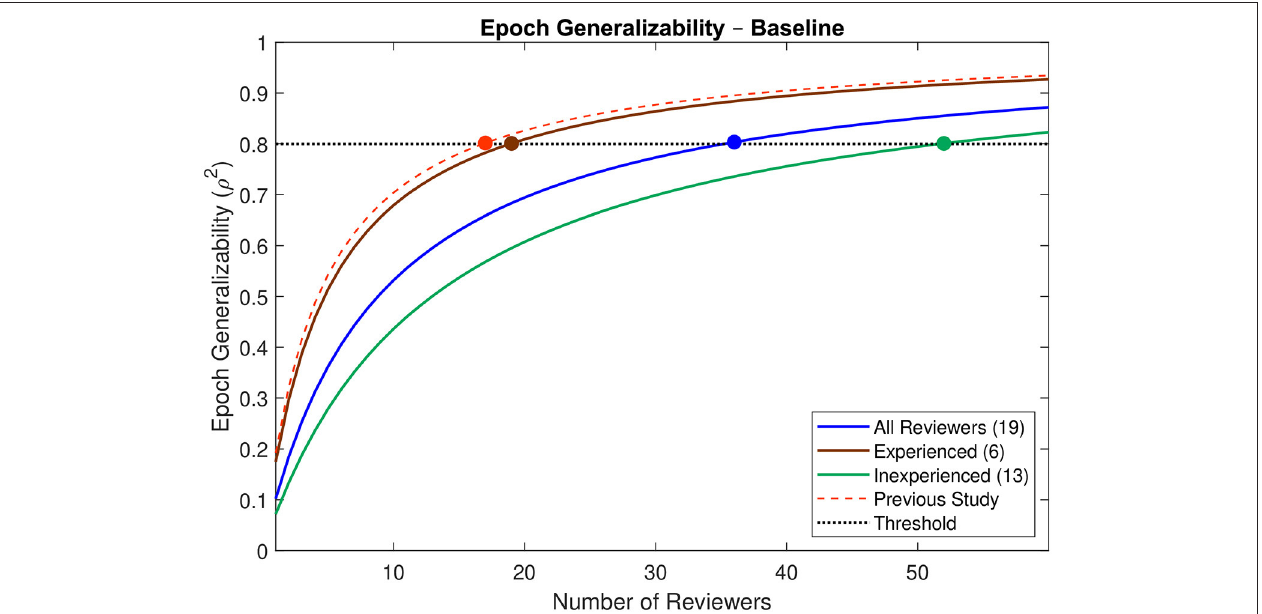
FIGURE 4 | Decision study projections for epoch generalizability at baseline. Projections of the epoch generalizability based on the number of reviewers are presented for all 19 reviewers (blue line), for the six experienced reviewers (brown line), and for the 13 inexperienced reviewers (green line). The decision study projections from the previous study (9) are indicated by the dashed red line. The threshold of 0.8 is indicated by the dotted black line, and the number of reviewers projected to be required to achieve the threshold in each case is indicated by a colored